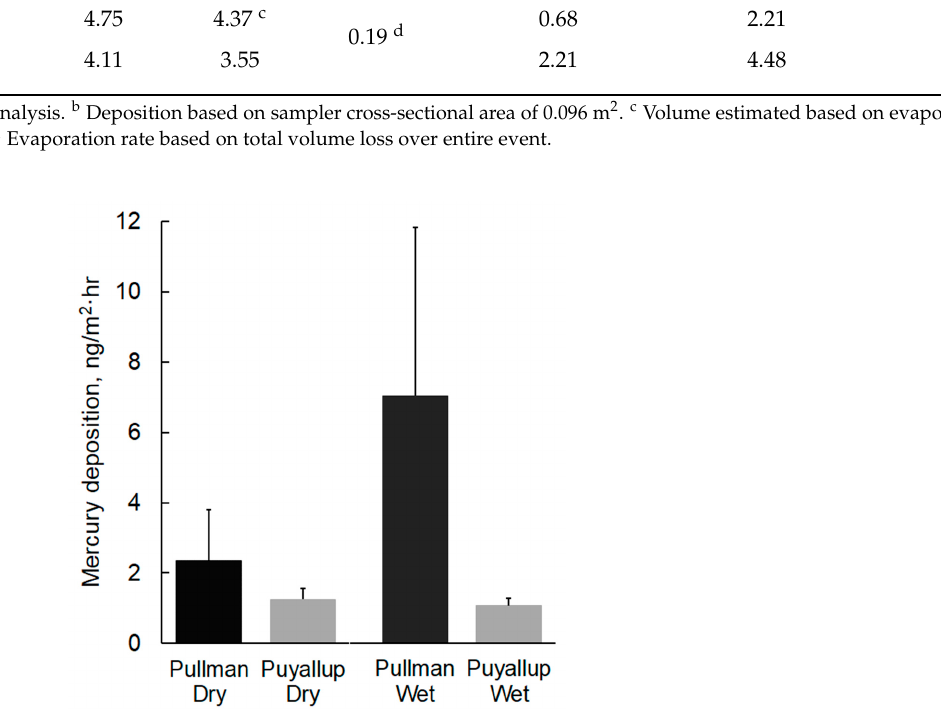
Figure 3. Dry and wet Hg deposition at Pullman and Puyallup, WA. Values are mean plus one standard deviation ( n = 3–6). Table 2. Mercury wet deposition.